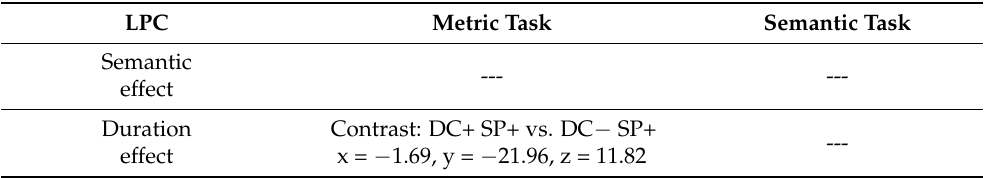
Table 6. Maximal statistical difference at Talairach coordinates for the significant contrasts detected in the late window. LPC Metric Task Semantic Task Semantic --- --- effect Duration Contrast: DC+ SP+ vs. DC − effect